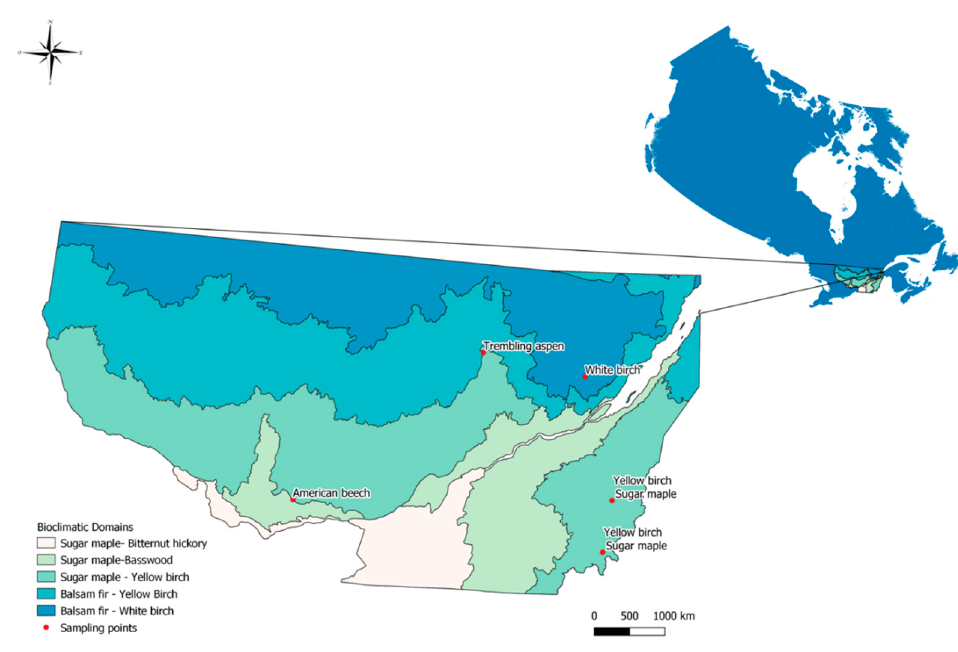
Figure 1. Location of sampling points. Table 1. Description of sampled material.